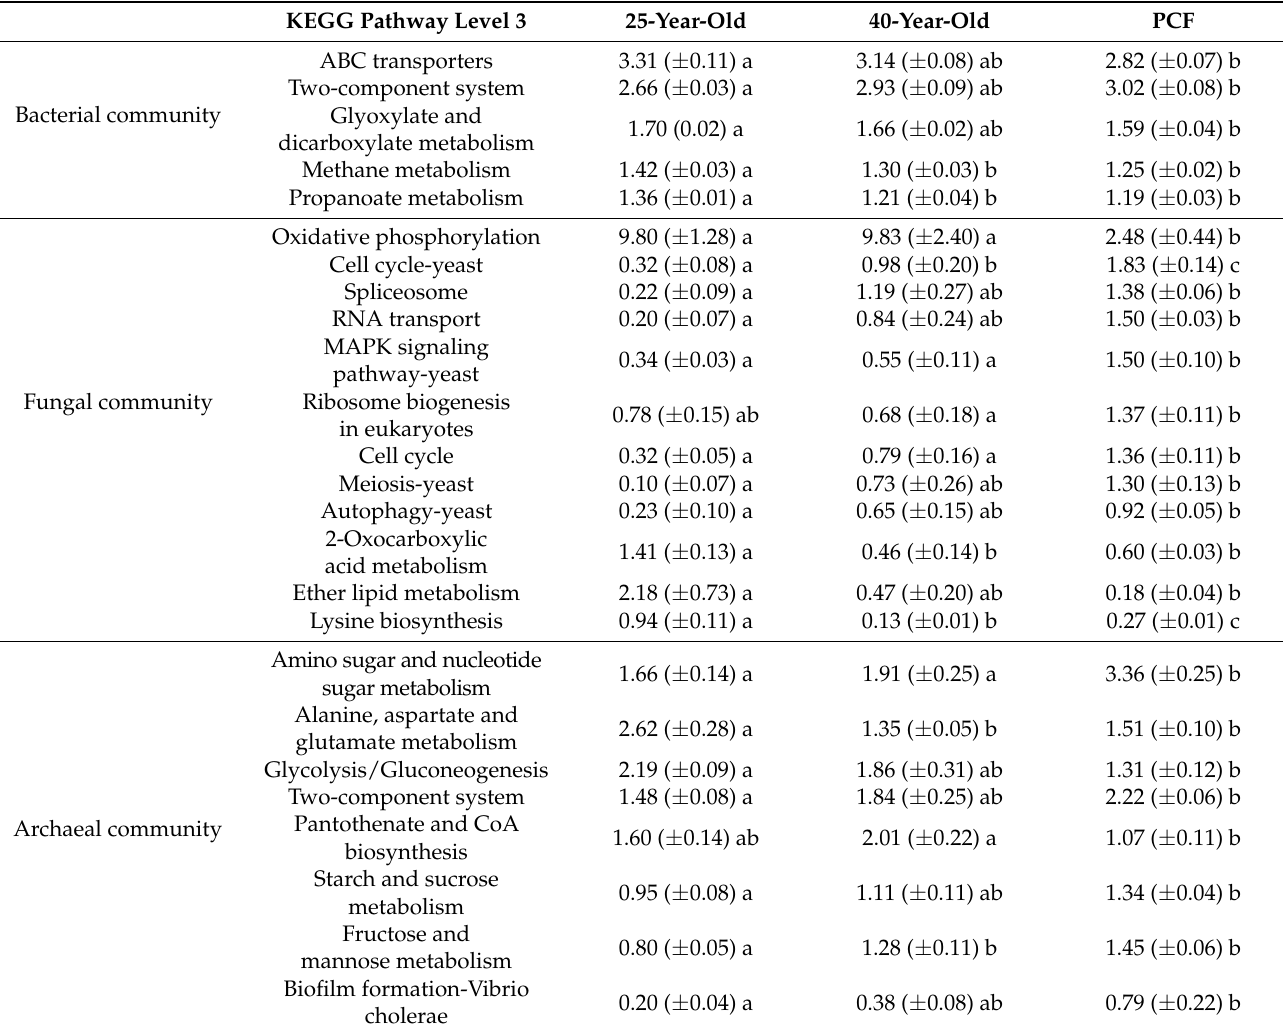
Table 4. The differences in relative abundance (%) of the soil microbial functional gene categories in the three